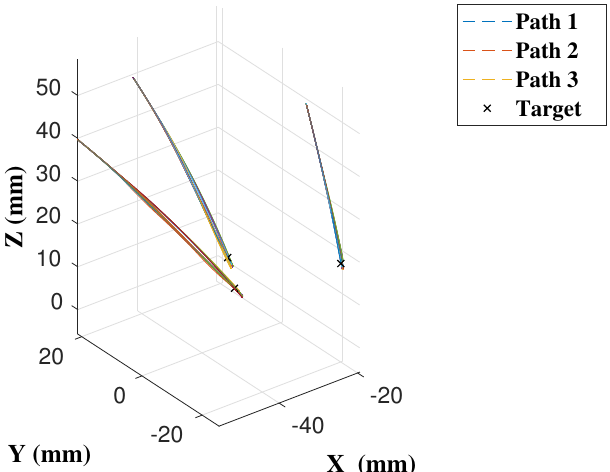
Figure 12. Catheter trajectories of the expert user, where each trajectory is from a different starting point in the skull to a different target located roughly centrally in the